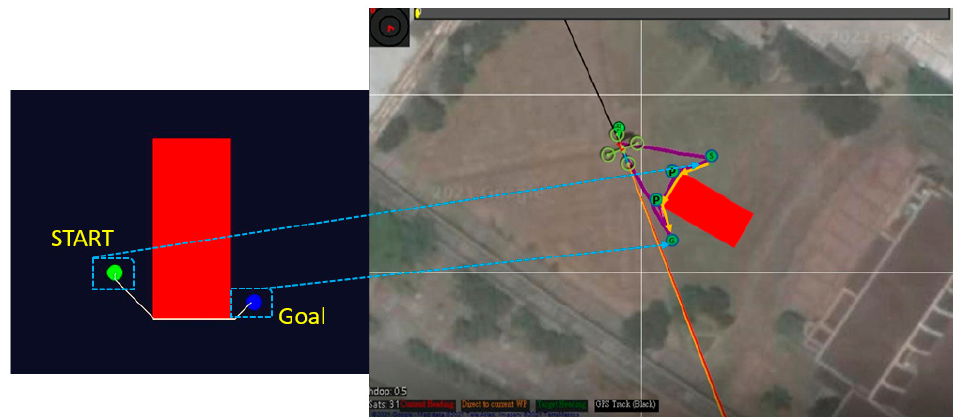
Figure 31. The Q-learning path on the map for Experiment 1.